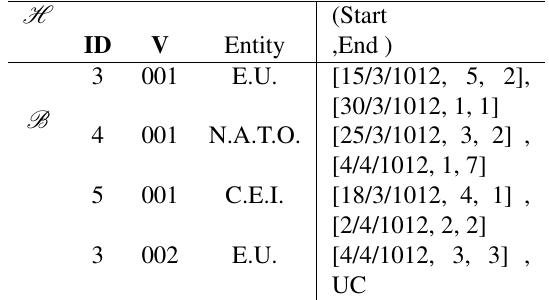
Table 13. Sample historical